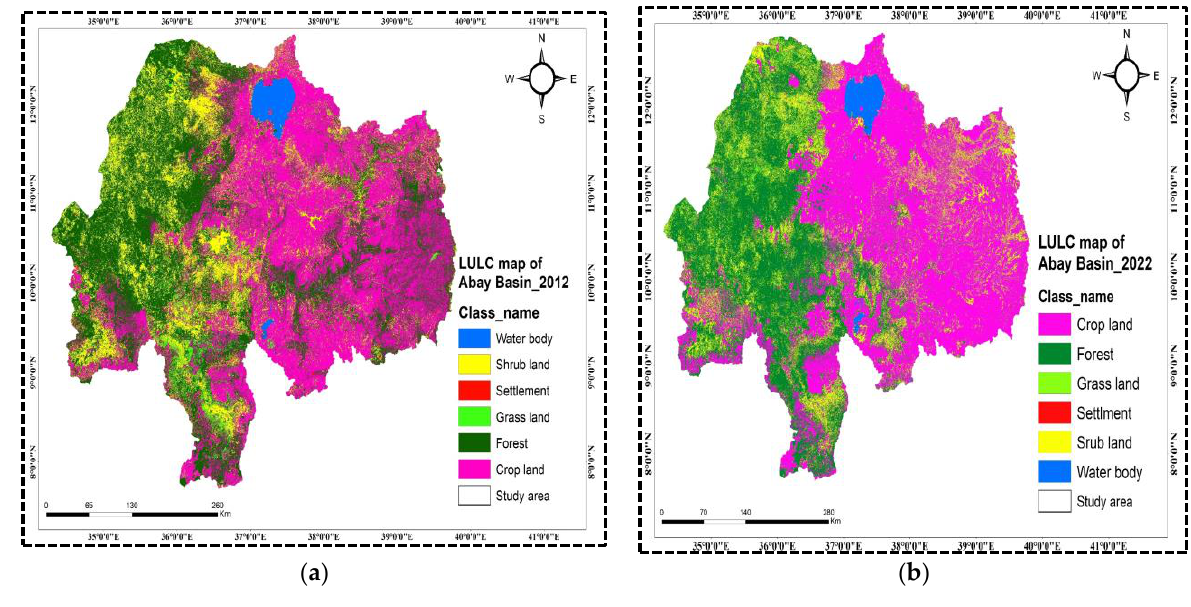
Figure 2. LULC in ( a ) 2012 and ( b ) 2022. Table 2. Land use/land cover change detection in the Nile/Abay river basin during 2012 and 2022.